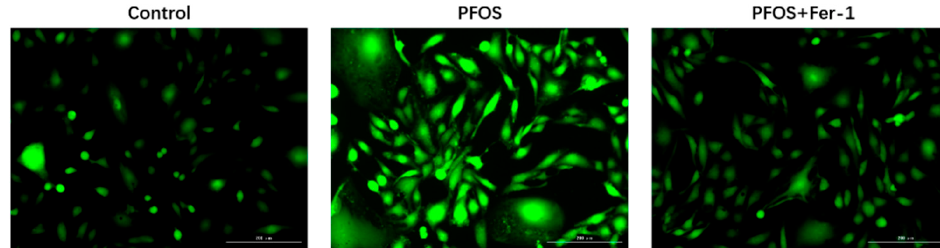
Figure 4. ( A ) ROS production determined by flowcytometry. HK ‐ 2 cells were exposed to PFOS at 200 μ M for 12 h or/and cultured with Fer ‐ 1 at 1 μ M for 2 h prior to exposure to PFOS. The excitation wavelength and emission wavelength were 488 nm and 525 nm, respectively. ( B ) Comparison of fluorescence intensity in HK ‐ 2 cells exposed to PFOS or/and Fer ‐ 1. HK ‐ 2 cells were exposed to PFOS at 200 μ M for 12 h or/and cultured with Fer ‐ 1 at 1 μ M for 2 h prior to exposure to PFOS; the results were from three independent experiments. Data were expressed as mean ± SD (n = 3); **** p < 0.0001.